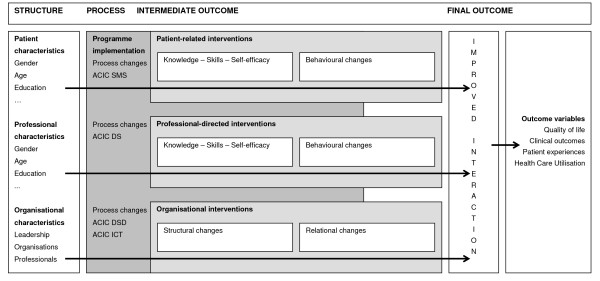
Relational model.